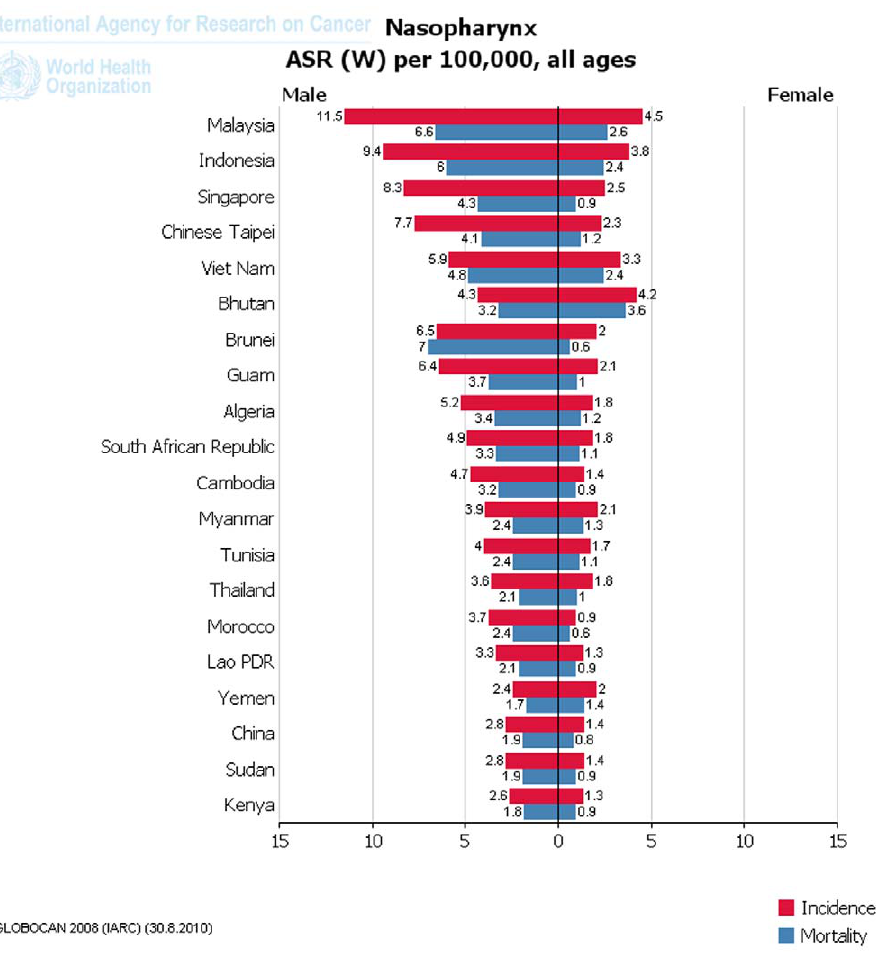
Figure 3. National incidence (red) and mortality (blue) of NPC demonstrated as ASR per 100,000 people-years from GLOBOCAN2008 database.